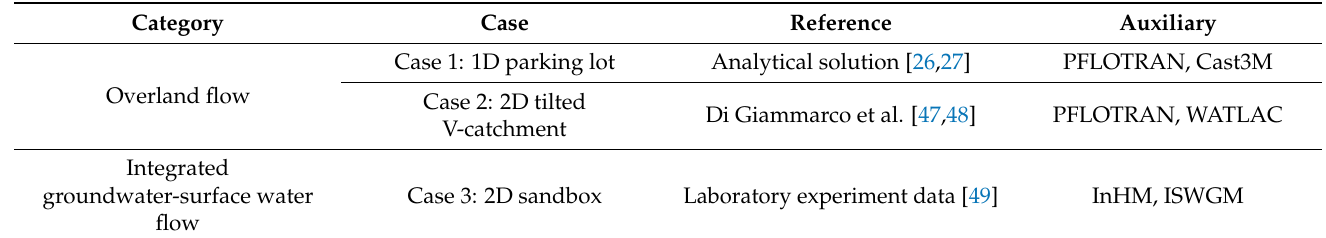
Table 2. A summary of reference data used in the benchmarking cases.